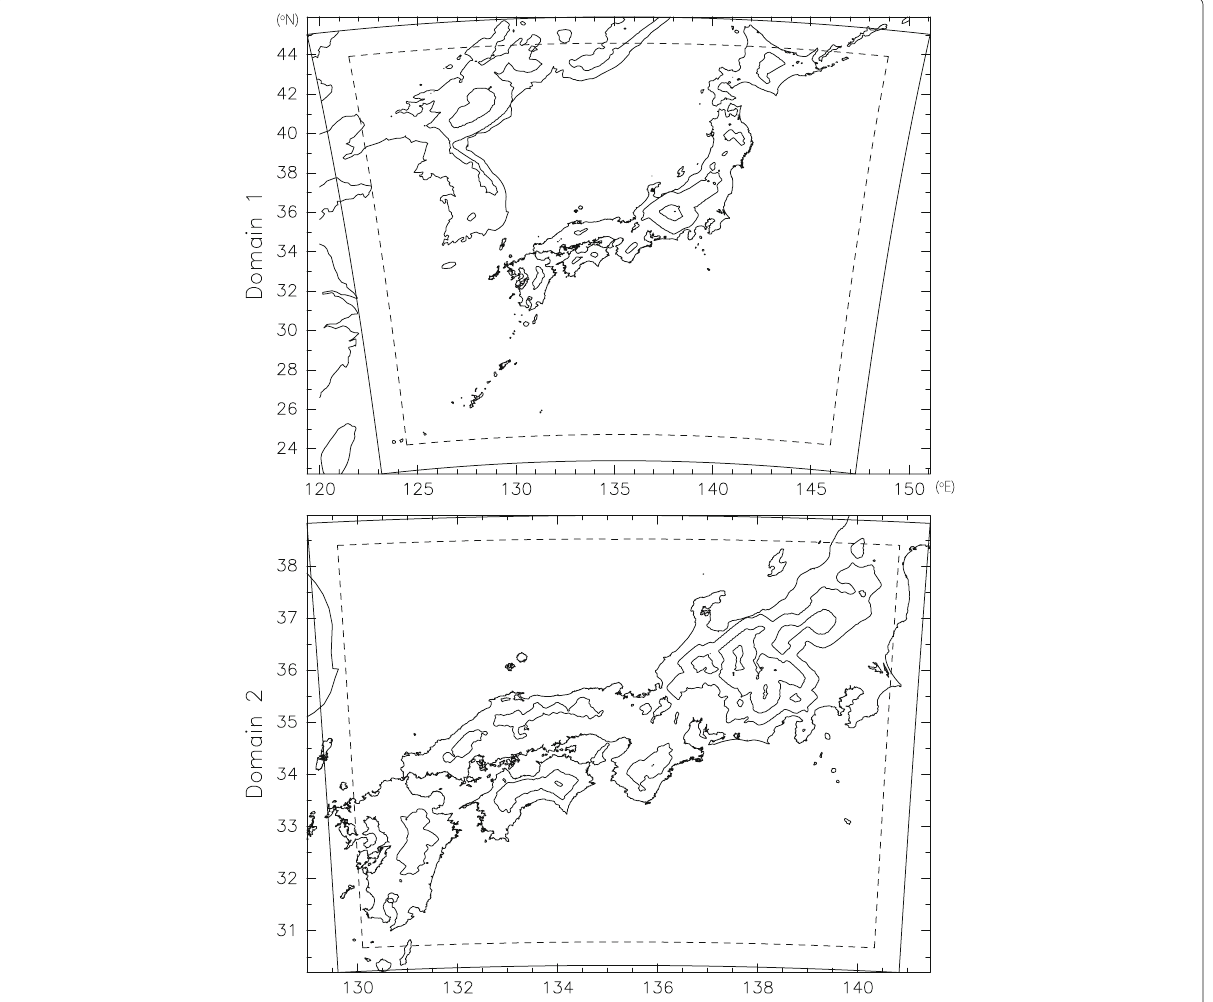
Fig. 6 Domain (top) 1 and (bottom) 2 for the numerical simulation in the demonstration. Contours represent surface elevation in the simulation and their interval is 500 m. The broken line shows the lateral nudging region (outmost 20